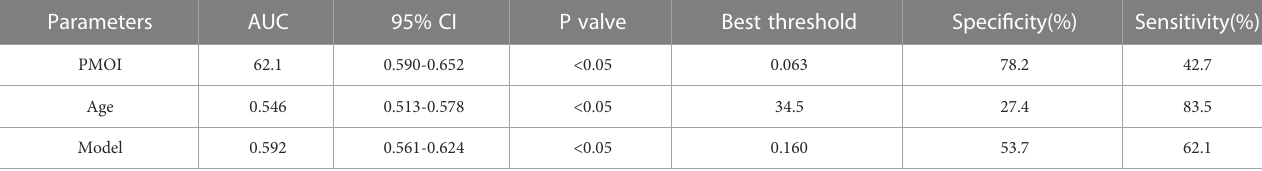
TABLE 3 Accuracy of different variables and model in IVF/ICSI to predict clinical pregnancy rate.